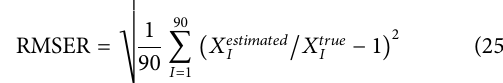
Table 3 indicates the lower and upper bounds of the unknowns in the search for solutions.